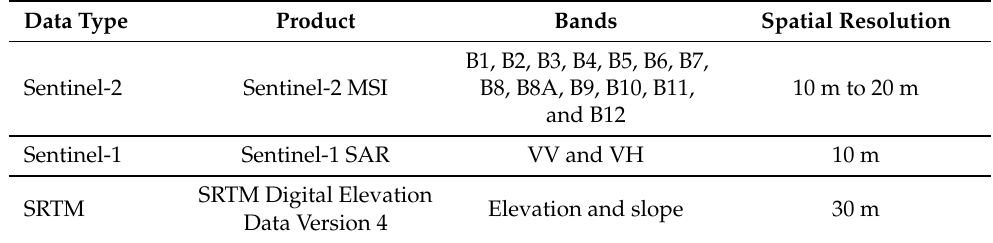
Table 2. Details of Hunan data modalities.